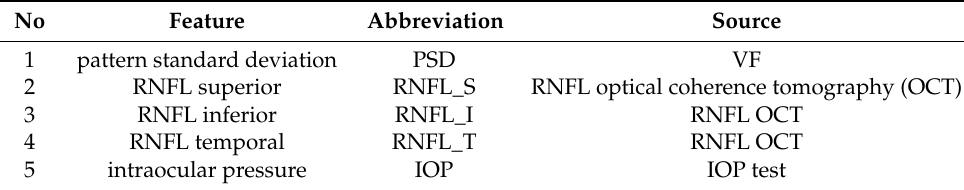
Table 3. Final features list for building the prediction model.